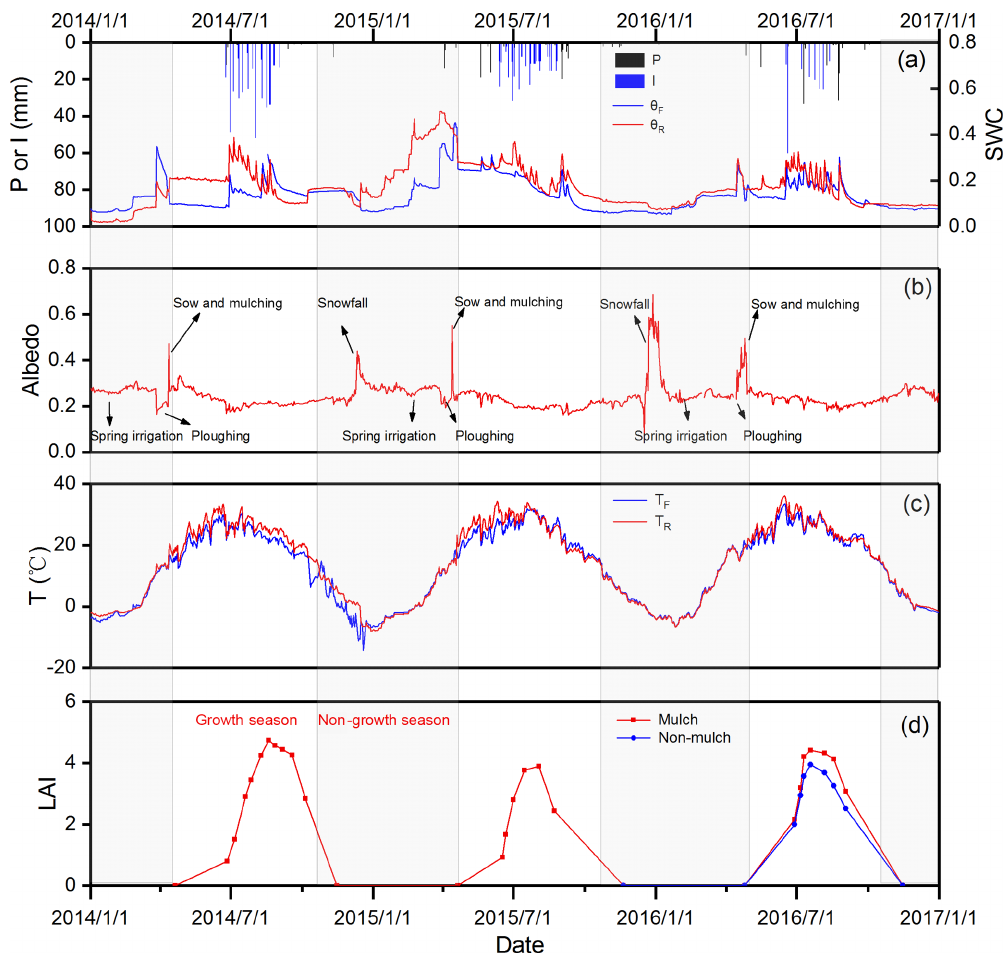
Figure 2. Environmental factors and crop growth in the PFM field under drip irrigation: (a) SWC in the ridge ( θ R ) and furrow ( θ F ) affected by irrigation and precipitation, (b) albedo affected by cultivation practices and snowfall in the mulched field, (c) T (soil temperature) in the furrow ( T F ) and ridge ( T R ) in the mulched field, and (d) LAI in the mulched and non-mulched fields (comparative LAI measurements were only conducted in 2016). The shaded area indicates the non-growing